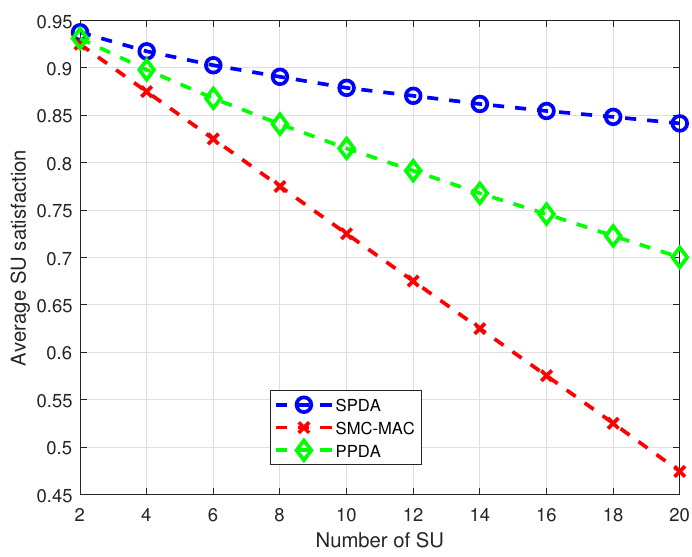
Figure 5. Average SU satisfaction at different numbers of SU.